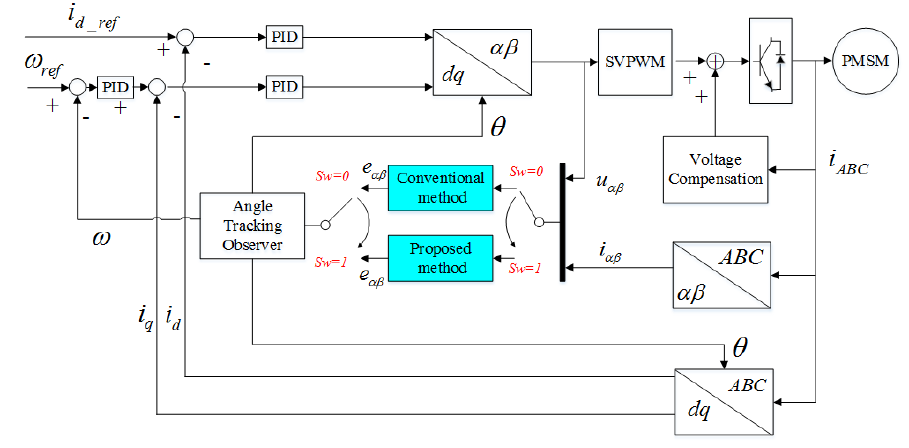
Figure 4. Rotor position and speed estimation